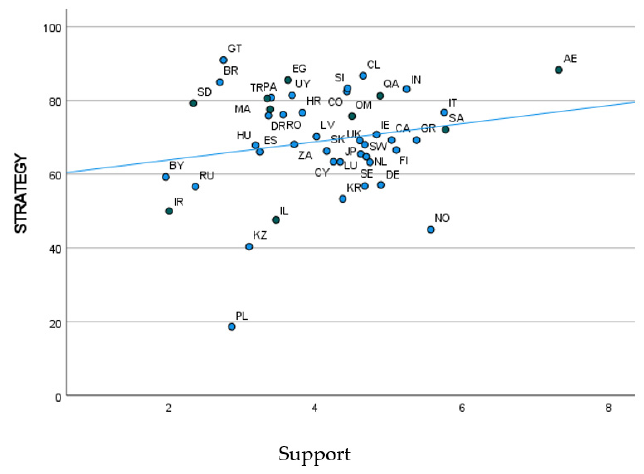
Figure 4. Countries plotted according to their support for sustainability and aggregate strategy for sustainability. Sources: Support and strategy are based on national-level data, described in section on research method.